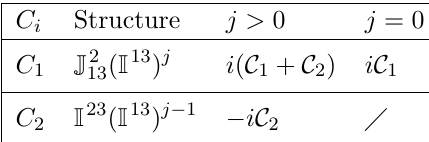
Table 10 . Expansion of the supersymmetric correlator in the component spin ( 1 j; 0). 2